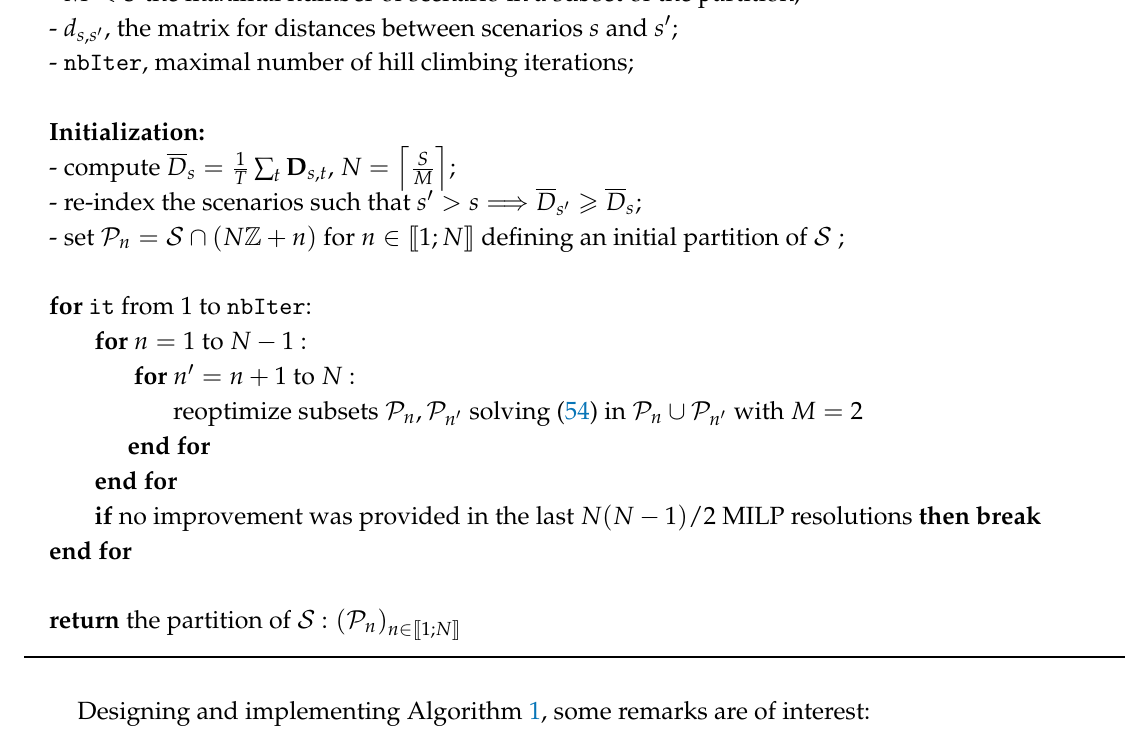
Algorithm 1 Partitioning HC matheuristic to maximize the diversity of